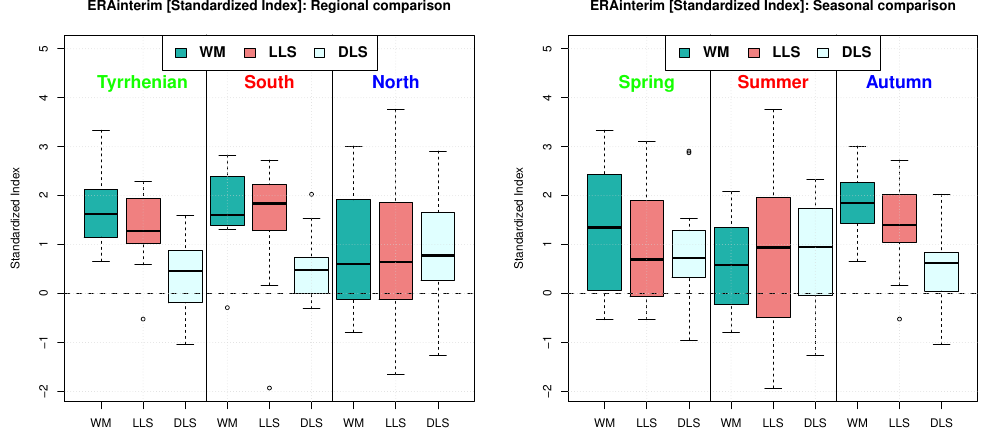
Figure A3. Same as Figure 4 but considering the ERA-Interim